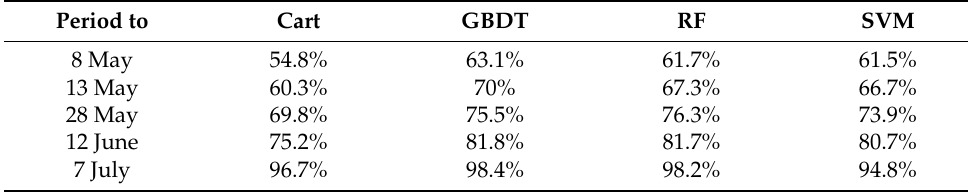
Table 18. Accuracy of soybeans identification in 2020 different